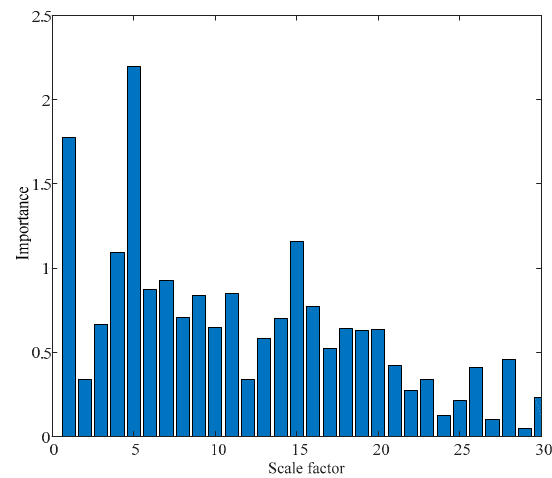
Figure 24. The importance of each scale factor for the MLZC method.